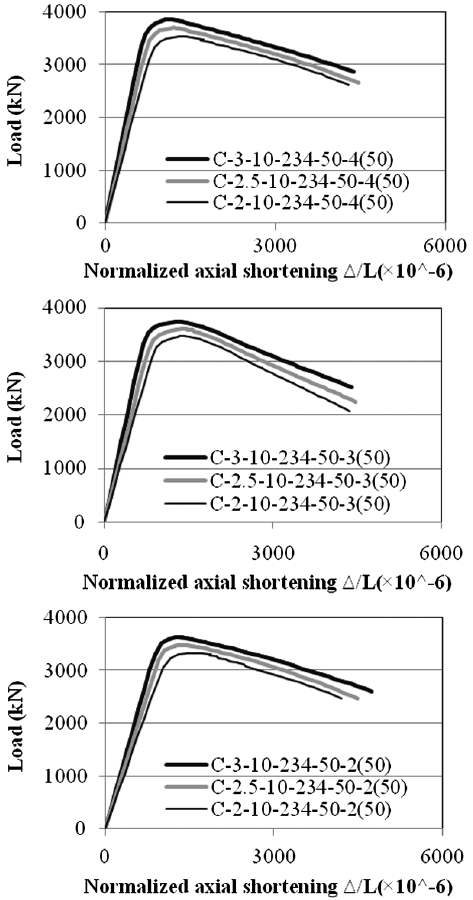
Fig. 11. Effect of steel wall thickness on ultimate axial load capacity